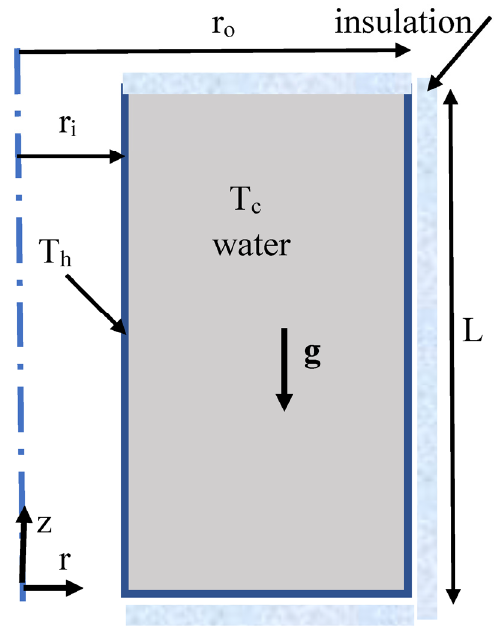
Figure 1. Schematic of the problem with the coordinate system.